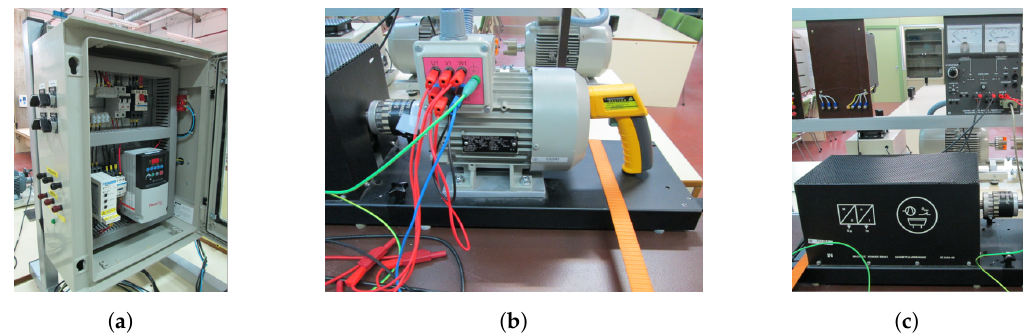
Figure 1. Experimental test bench. ( a ) inverter; ( b ) induction motor; ( c ) magnetic powder brake.